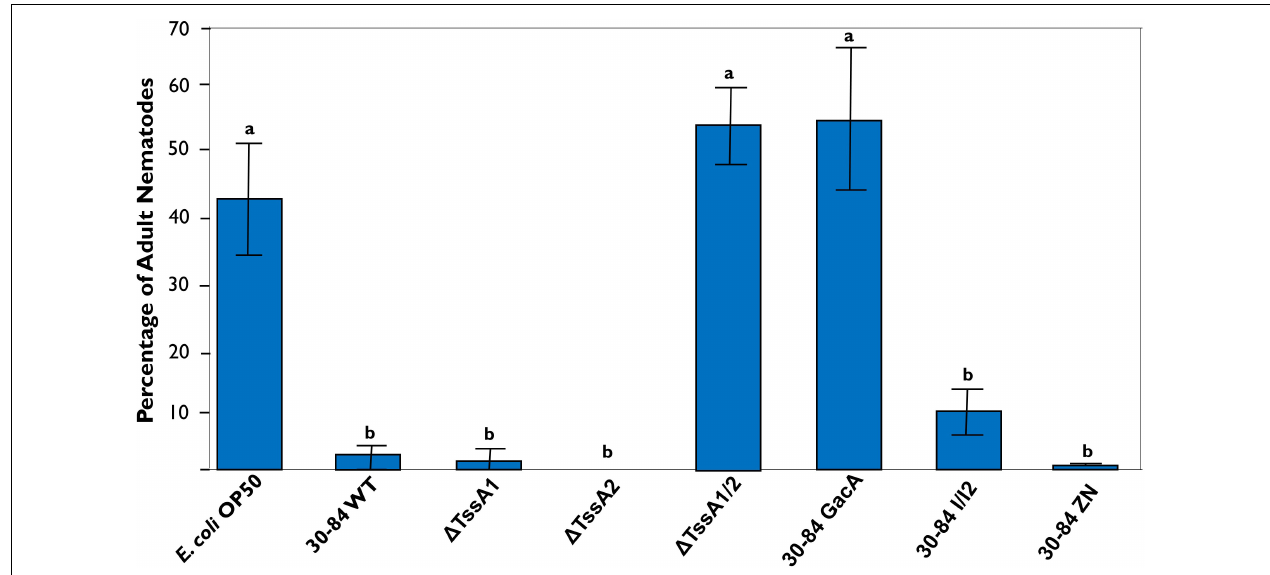
FIGURE 9 | Percentage of C. elegans that reach maturity after 72 h. Five adult C. elegans were transferred at 1-h intervals to new prey-containing plates to facilitate egg laying (a total of four successive transfers), and then the percentage of nematodes maturing to adults were measured every 24 h over a 72-h period. Plates contained either 30–84 WT, (cid:49) TssA1, (cid:49) TssA2, (cid:49) TssA1/2, 30–84 GacA, 30–84 I/I2, 30–84 ZN, or E. coli OP50 (control) as a food source. Data are the mean and standard errors of three replicate experiments (four plates/replicate). Data were analyzed using one-way ANOVA and Tukey tests. Letters indicate significant differences, p <